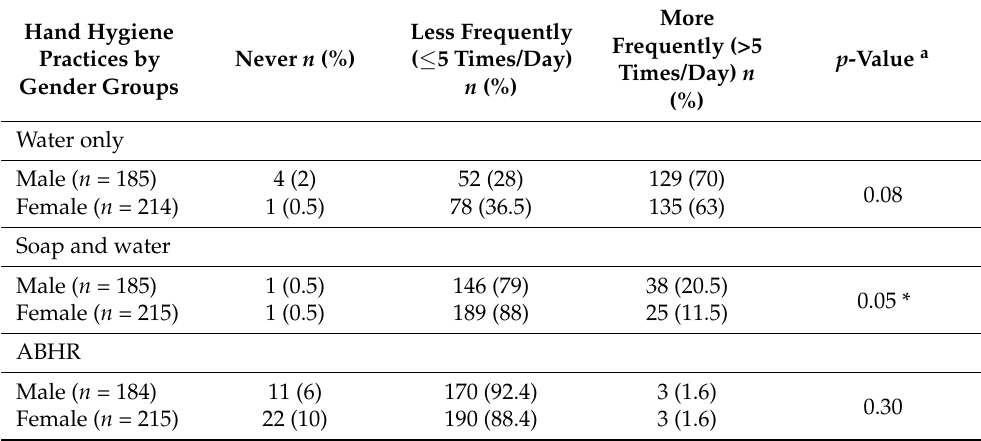
Table 4. Frequency of reported practice of hand hygiene methods in both gender groups ( n = 400).